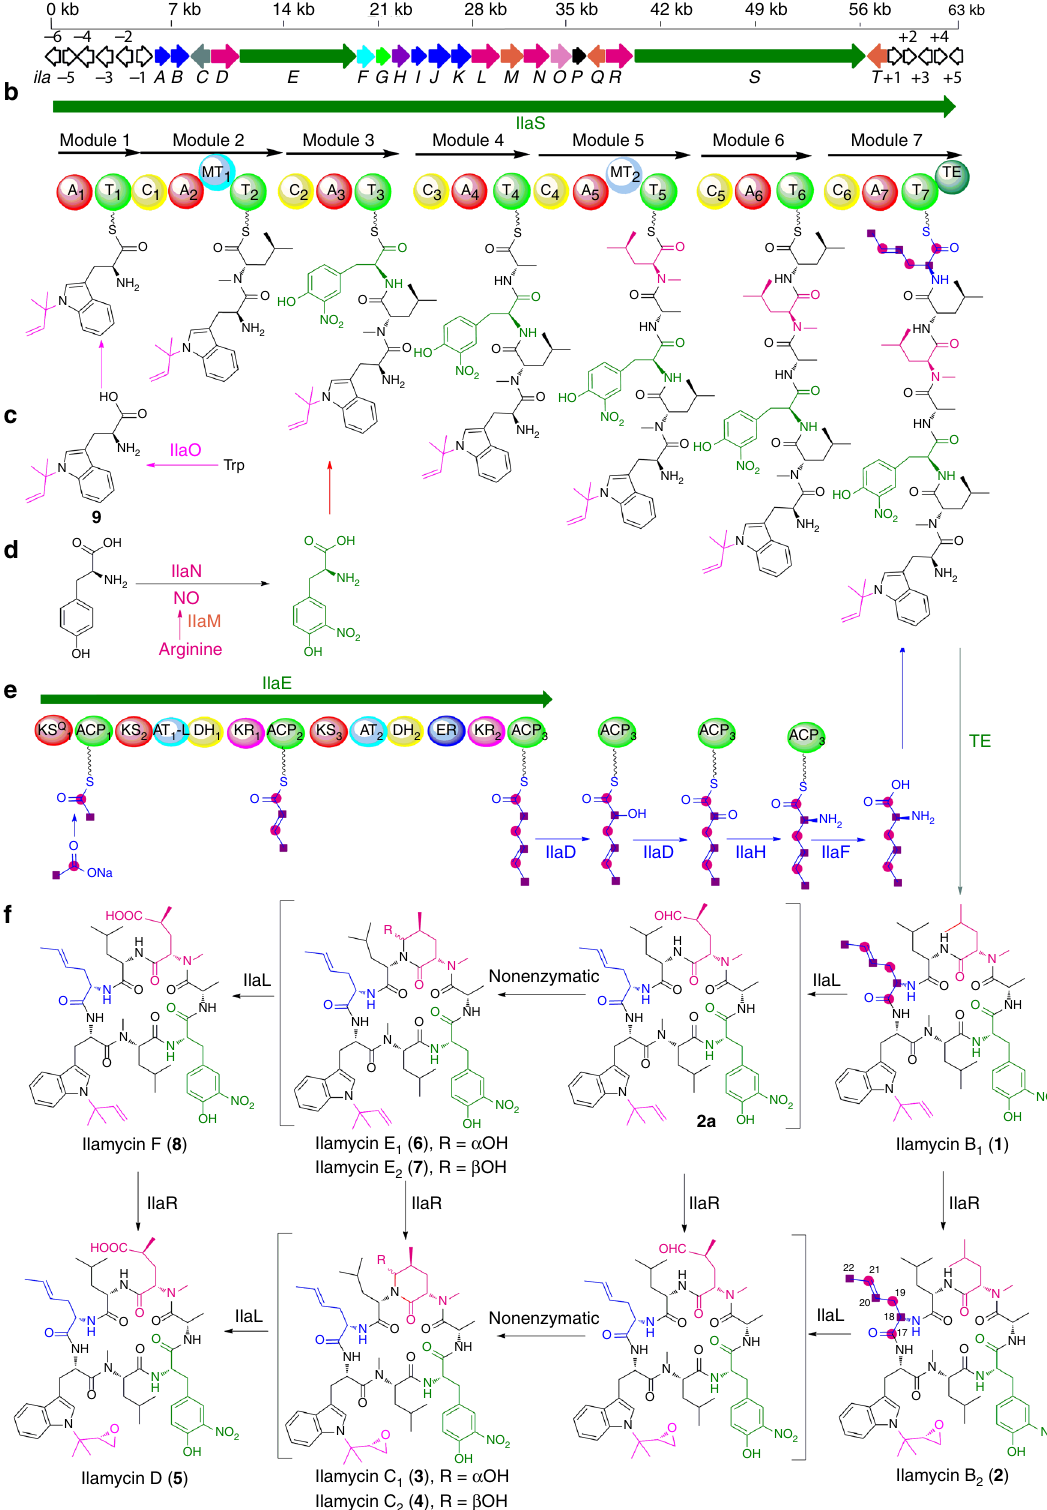
Fig. 3 Biosynthetic gene cluster and proposed biosynthetic pathway of ilamycins. a Organization of the ilamycin gene cluster. b Biosynthetic pathway of ilamycins. c The prenylation of Trp. d The nitration of Tyr. e The biosynthesis of L -AHA unit. f The post-tailoring biosynthetic steps en route to ilamycins. A adenylation, C condensation, T thiolation, MT methylation, TE thioesterase, KS keto synthases, ACP acyl carrier protein, AT acyl transferase, AT-L acyl transferase-like protein, DH dehydratase, KR keto reductase, ER enoyl